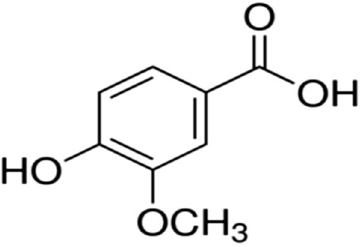
Fig. 16 Structure of vanillic acid (4-hydroxy-3-methoxybenzoicacid)